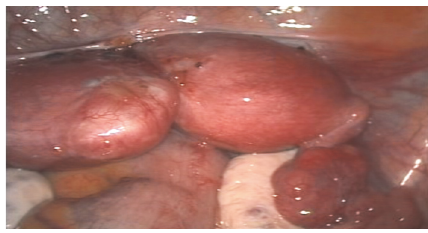
Figure 2: Laparoscopy